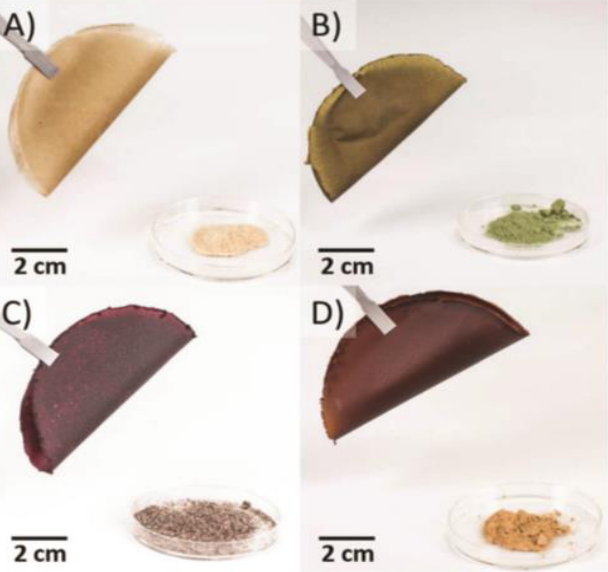
Figure 2. Bioplastic films obtained from vegetable wastes in mild aqueous conditions: ( A ) carrot bioplastic; ( B ) parsley bioplasgtic; ( C ); radicchio bioplastic; ( D ) cauliflower bioplastic.(Reprinted with permission from Ref. [89]. Copyright 2018 Royal Society of Chemistry.)